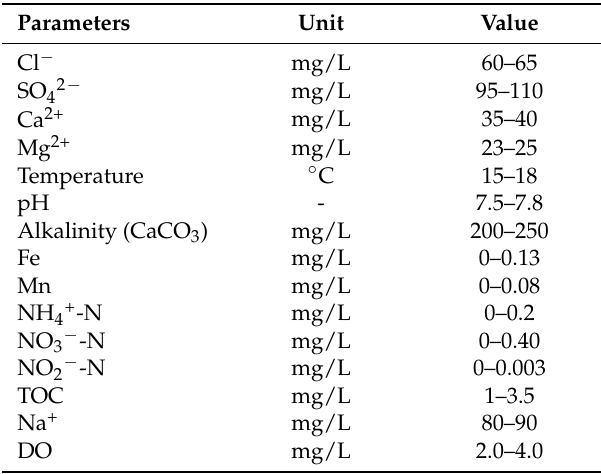
Figure 1. Schematic illustration of the pilot-scale filter system. Table 1. Chemical composition of the feed water.